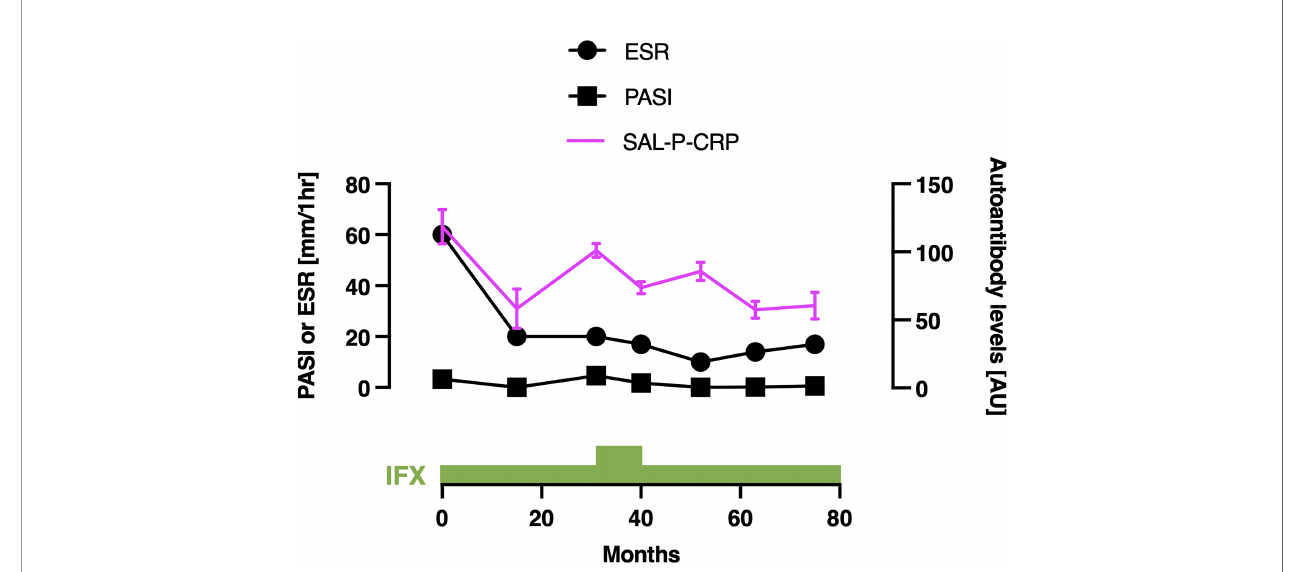
FIGURE 7 | Serial measurements of pulmonary function and autoantibody level in a patient with psoriatic arthritis. Scales for psoriasis area and severity index (PASI) and erythrocyte sedimentation rate (ESR) are shown on the left, and the scale for sum of autoantibody levels that positively correlated with serum C-reactive protein levels (SAL-P-CRP) is shown on the right. The values of SAL-P-CRP are described as the mean and the standard error of the mean of technical triplicates. IFX, in fl iximab; AU, arbitrary